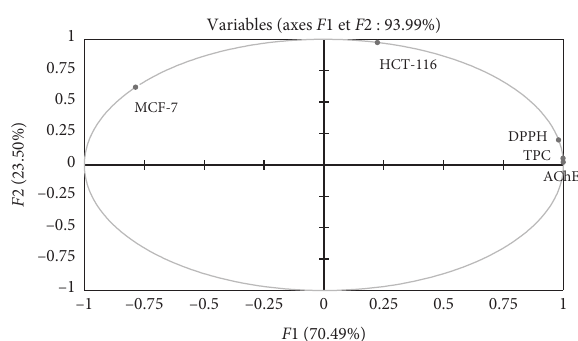
Figure 3: Principal components analysis loading plot of antioxi- dant and biological activities of R. crispus extracts. TPC: total phenolic content; AChE: antiacetylcholinesterase activity; DPPH: antioxidant activity; MCF-7: cytotoxicity 1; HCT-116: cytotoxicity 2.